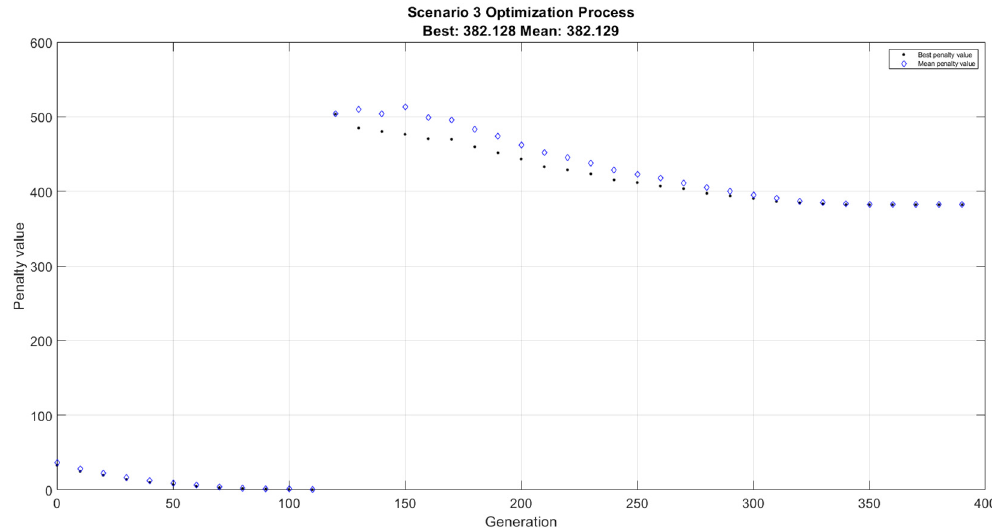
Figure 4. Scenario 3 optimization process.